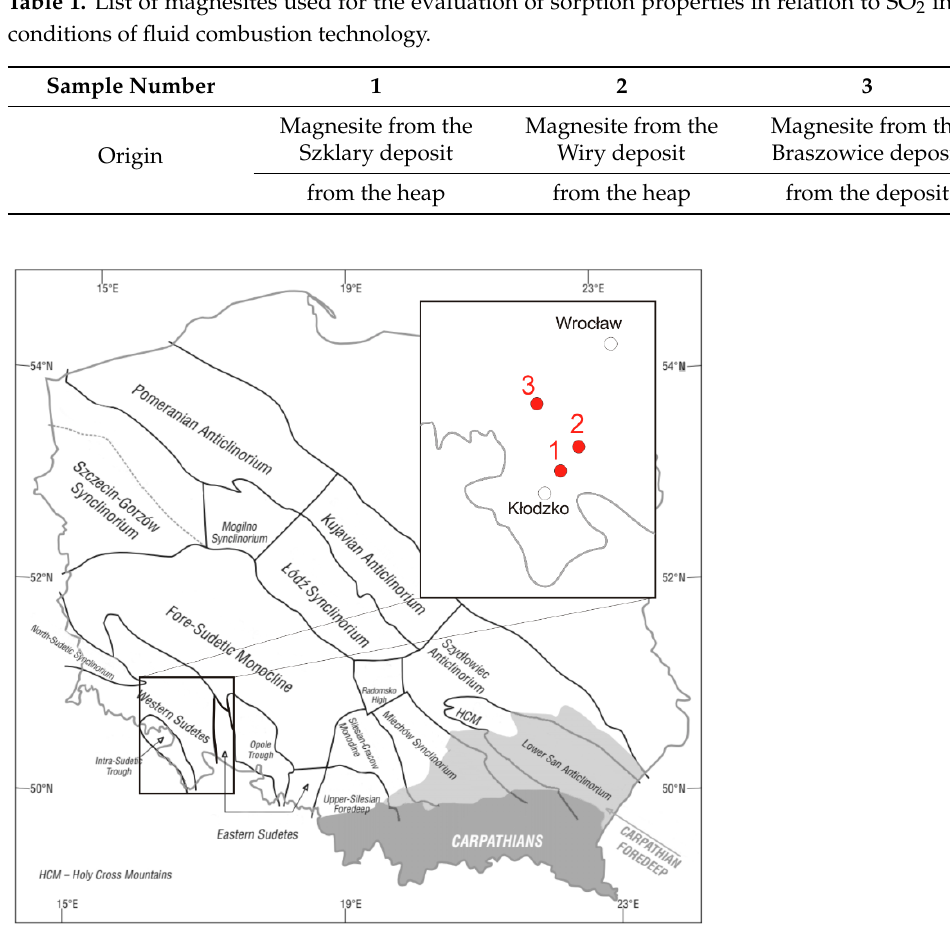
Figure 1. Locations of magnesite deposits from which materials were collected for this research, against the background of the main tectonic units on the sub-Cenozoic surface of Poland [17]. 1—Szklary deposit; 2—Wiry deposit; 3—Braszowice deposit.